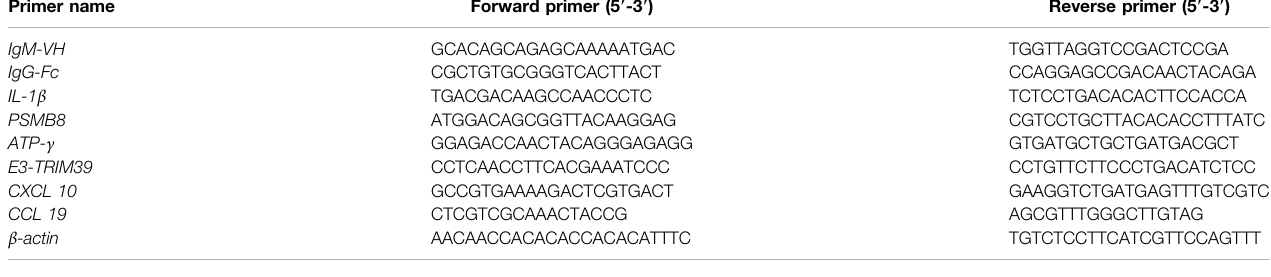
TABLE 1 | Primers used in this study.